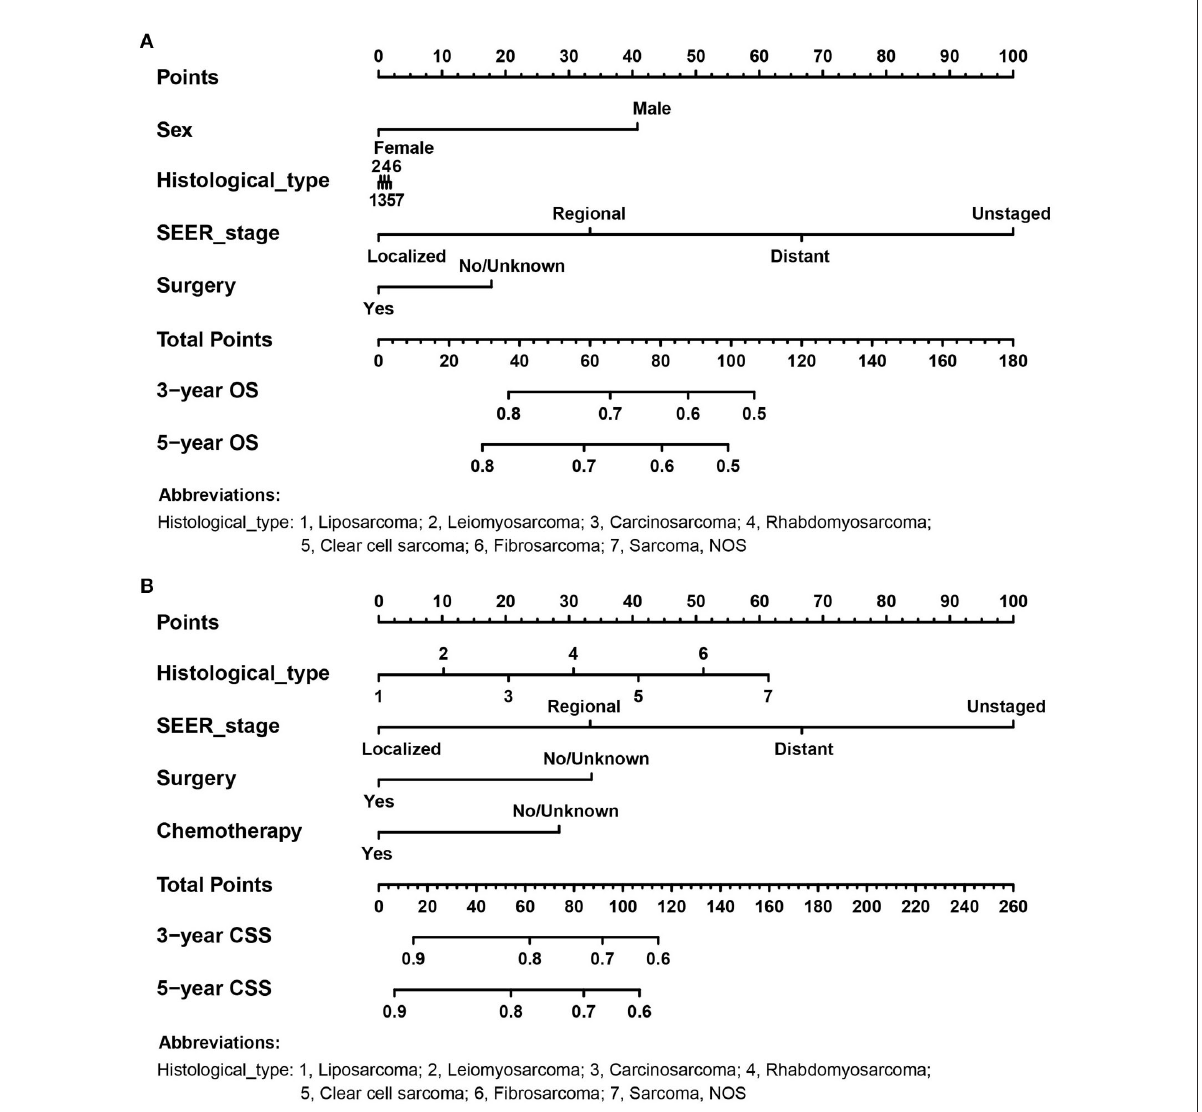
FIGURE2 The prognostic nomograms for predicting 3- and 5- OS and CSS probabilities of adult RS patients in the training cohort. (A) OS nomogram; (B) CSS nomogram.